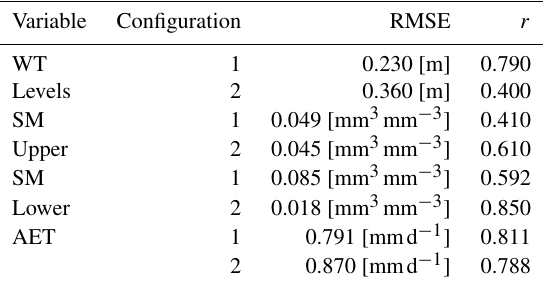
Table 2. Results for the calibrated runs.